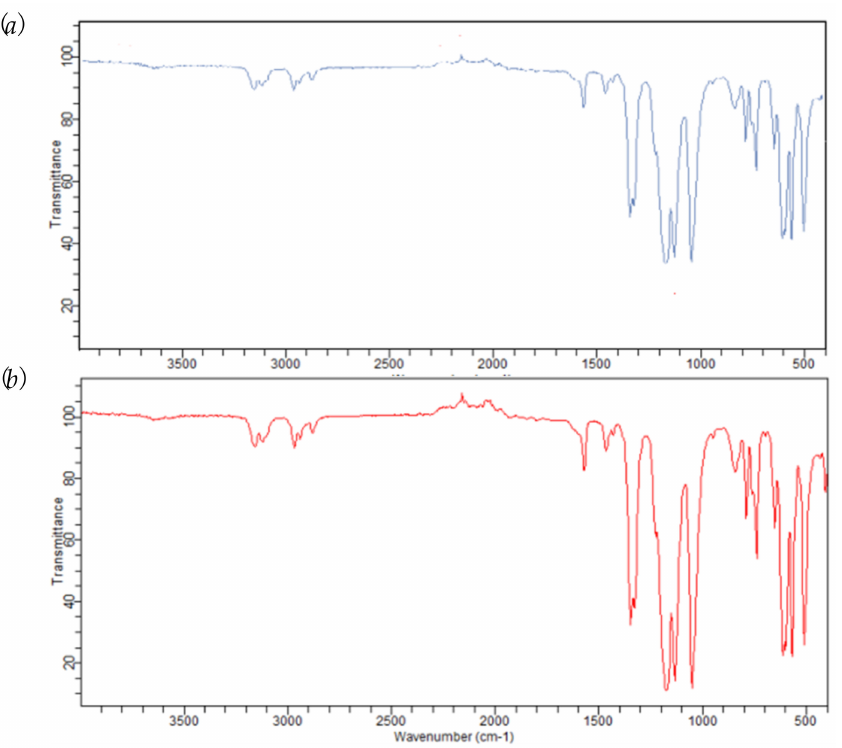
Figure 5. Infrared spectra in the 500–4000 cm − 1 range of ( a ) [FeCl 2 { κ 3 -HC(pz) 3 }]/[bmim][NTf 2 ] and ( b ) FeCl 2 { κ 3 -HC(pz) 3 }]/[bmim][NTf 2 ] after the 4th catalytic